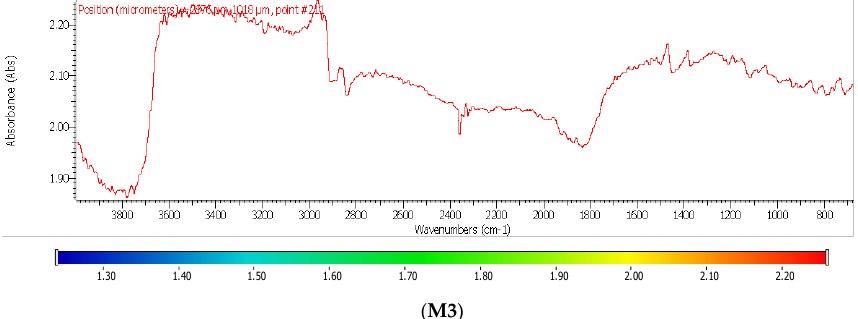
Figure 9. Infrared associated spectrum and colour scales for sulfonated ethylene-propylene-diene terpolymer (sEPDM) membrane ( M1 ); chitosan-sulfonated ethylene-propylene-diene terpolymer (Chi-sEPDM) membrane ( M2 ), and melatonin-chitosan-sulfonated ethylene-propylene-diene ter- polymer (Mel-Chi-sEPDM) membrane ( M3 ). The HD-IR obtained maps show a relatively uniform, regular, and repeatable distri- bution of the surface of the obtained membranes, especially for the sulfonated ethylene- propylene-diene terpolymer (sEPDM) membrane (M1). The composite chitosan-sul- fonated ethylene-propylene-diene terpolymer (Chi-sEPDM) membrane (M2), and mela- tonin-chitosan-sulfonated ethylene-propylene-diene terpolymer (Mel-Chi-sEPDM) mem- brane (M3) show areas that, with the greatest probability, are due to the agglomeration of chitosan or melatonin – chitosan (upper left corner of the images), being more obvious for a wave number of 3345 cm −1 , but also present for all other wave numbers (see Table 4). This agglomeration was also highlighted in the scanning electron microscopy details (Fig- ure 5c,e).